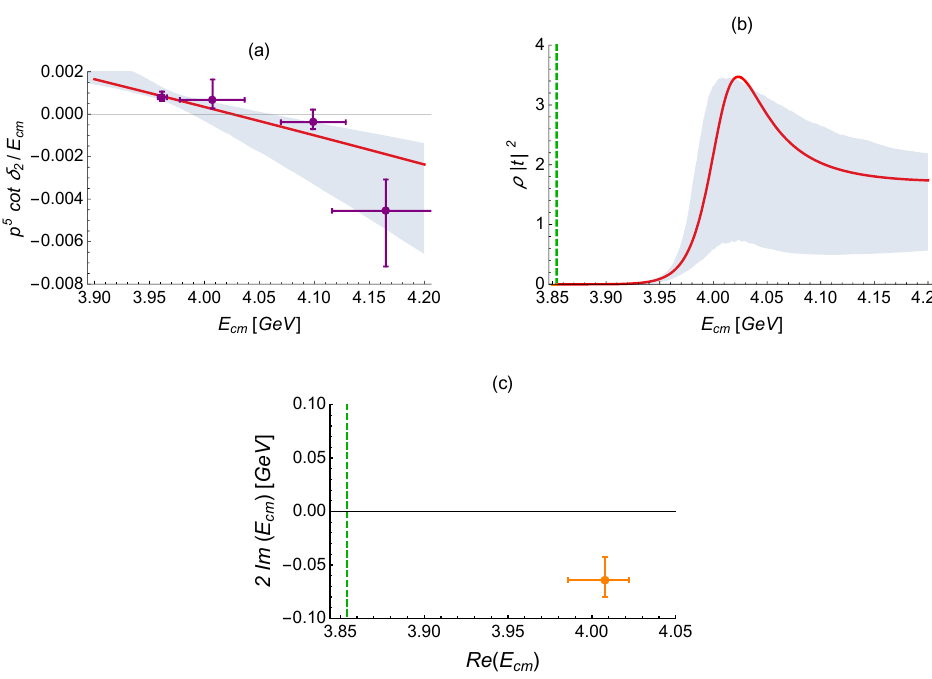
Figure 5 . D ¯ D scattering in partial wave l = 2 in the energy region around the conventional χ c 2 (3930) resonance. (a) The purple crosses show the quantity p cot δ/E cm and the red line repre- sents a simple Breit-Wigner resonance fit. (b) The quantity ρ | t | 2 that is proportional to the number of D ¯ D events in experiment N ∝ pσ ∝ ρ | t | 2 shows a resonance peak. (c) The position of the D s ¯ D s χ c 2 (3930) resonance pole E p = m − i Γ of the scattering matrix on sheet II from eq. cm 2